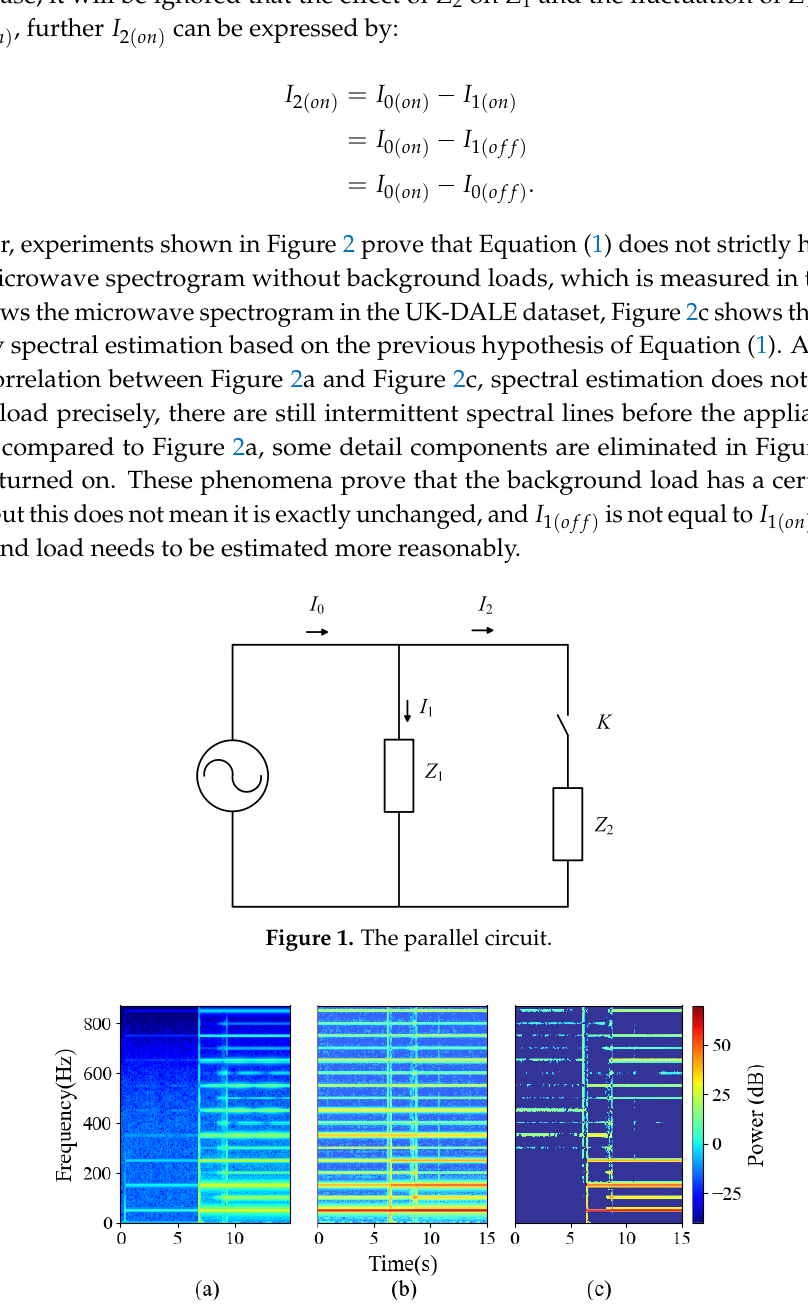
Figure 2. Spectrograms of microwave. ( a ) The spectrogram with no background load. ( b ) The spectrogram with background loads ( c ) The estimated